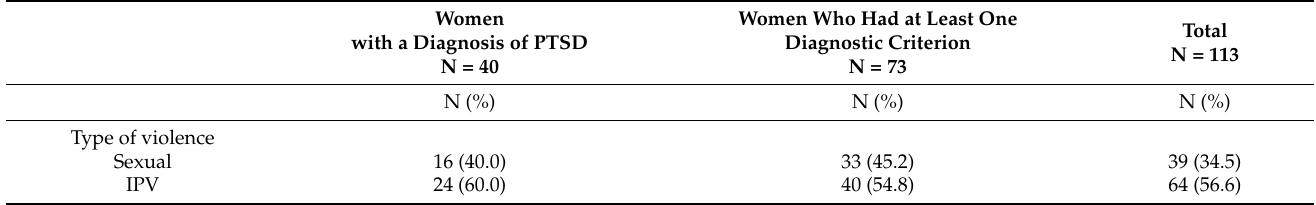
Table 2. Distribution of type of violence in the sample of women with PTSD ( n = 40) and those who had at least one diagnostic criterion of PTSD ( n = 73).